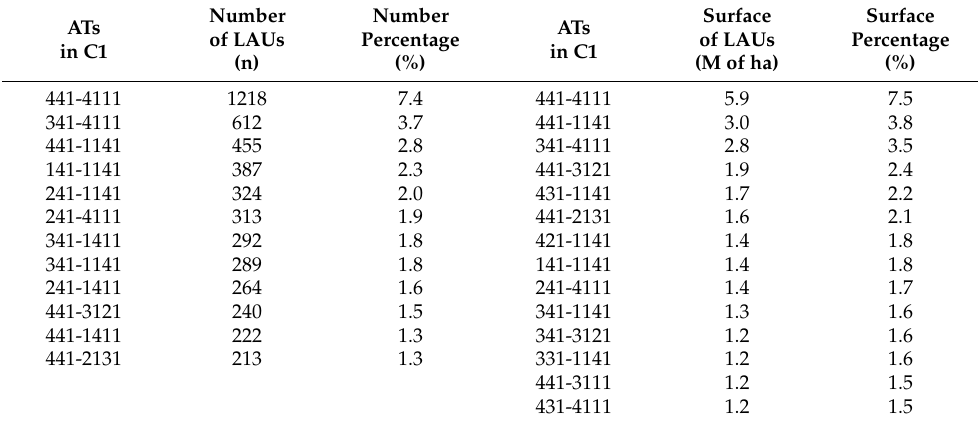
Table 4. The most representative agricultural typology (AT) identified for the first census date (C1) in terms of number of LAUs (>%1 of the total number) and surface of LAUs (> 1 M of ha). Number Number Surface ATs ATs of LAUs Percentage of LAUs in C1 in C1 (n) (%) (M of ha)